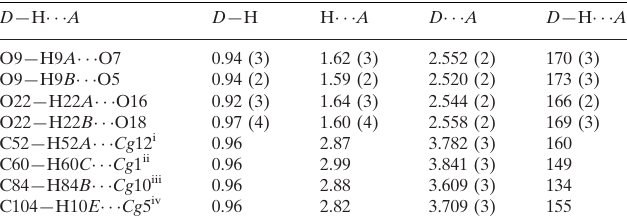
Data collection Bruker Kappa APEXII CCD area- detector diffractometer Absorption correction: multi-scan ( SADABS ; Bruker, 2005) Hydrogen-bond geometry (A˚ , (cid:3)